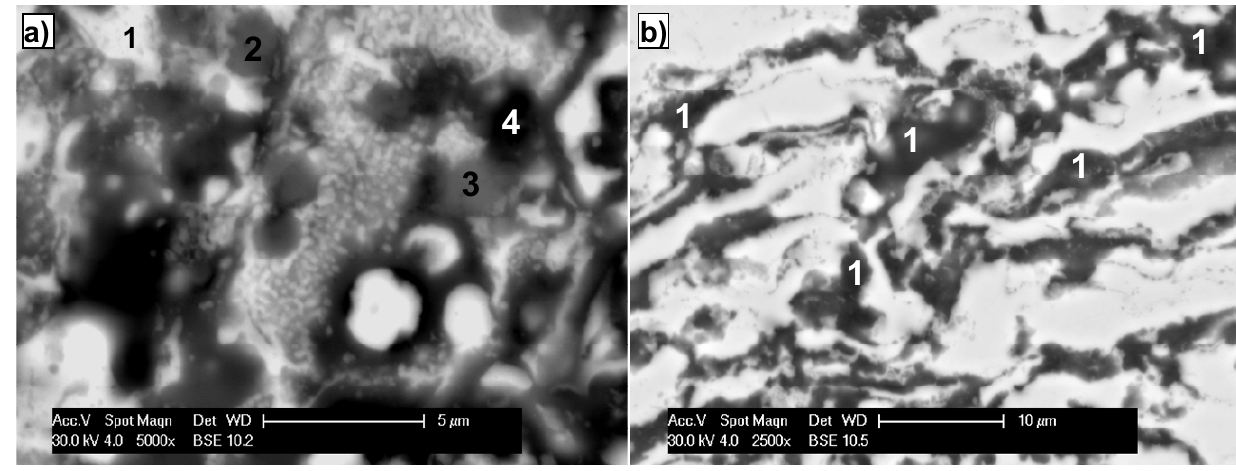
Figure 10. Example microstructure on the cross section of detonation sprayed FeAl intermetallic coating and after additional heat treatment at 750 °C for 10 h; hypothetical phase identification based on results of ( a ) EDS point analysis; and ( b ) dispersive Al 2 O 3 oxides.